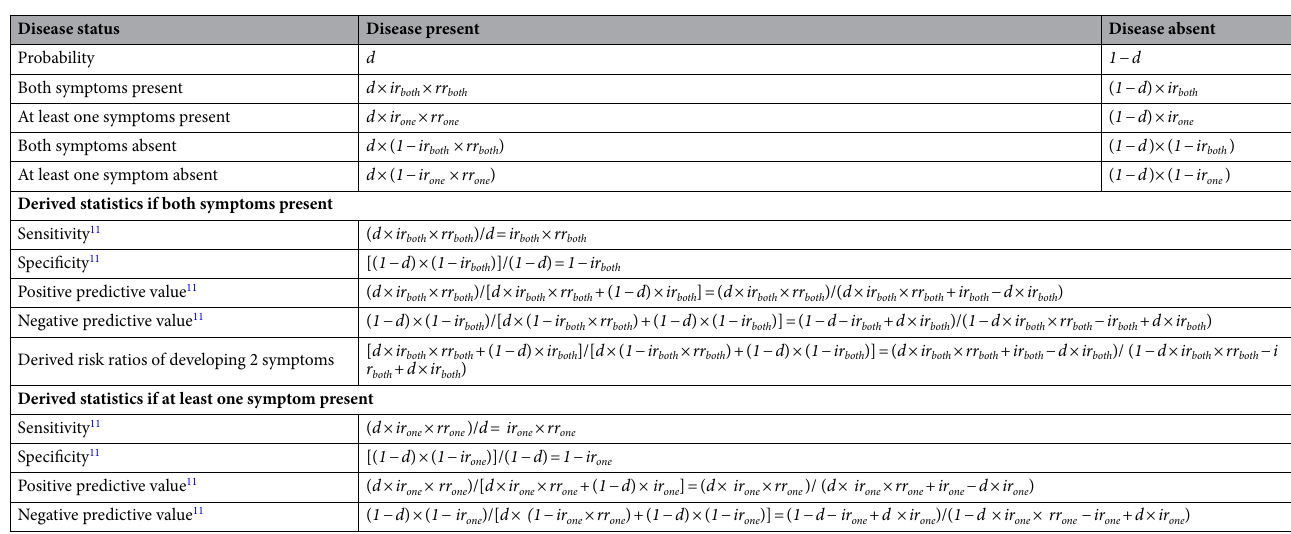
Table 2. Diagnostic accuracy of two symptoms to diagnose the disease cause in equations. Equations are derived based on Baratloo et al.’s definitions 11 . both both symptoms presenting due to the disease that caused the symptoms, d proportions in a population with the disease, ir symptom incidence rate, one one symptom presenting, rr risk